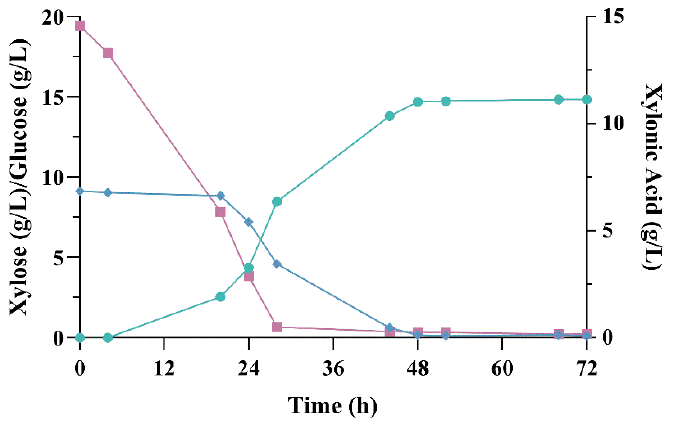
Figure 5. Production of xylonic acid from sugarcane bagasse hydrolysate. Fermentation was carried out in a bioreactor with defined medium containing 10% hemicellulosic hydrolysate of sugarcane bagasse in batch mode at 30 °C. Xylonic acid (green circles), xylose (blue diamonds) and glucose (purple squares).